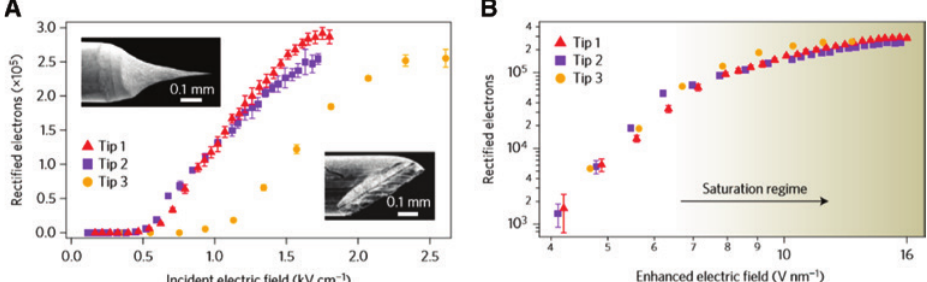
Figure 5: Rectified electrons from the nanotip. (A) Number of rectified electrons as a function of incident terahertz electric field, measured with three different metal tips. Electrochemical etching produces sharp tips (Tips 1 and 2), whereas mechanical cutting makes a blunt tip (Tip 3). Insets are SEM images of sharp (top) and blunt (bottom) tips. (B) Number of rectified electrons as a function of enhanced terahertz electric field for three different tips, in which the same behavior indicates that the tip geometry affects only the enhancement factor. The saturation regime (space-charge-limited regime) is achieved by strong field enhancement in metal nanotip. The figures are reproduced from Reference